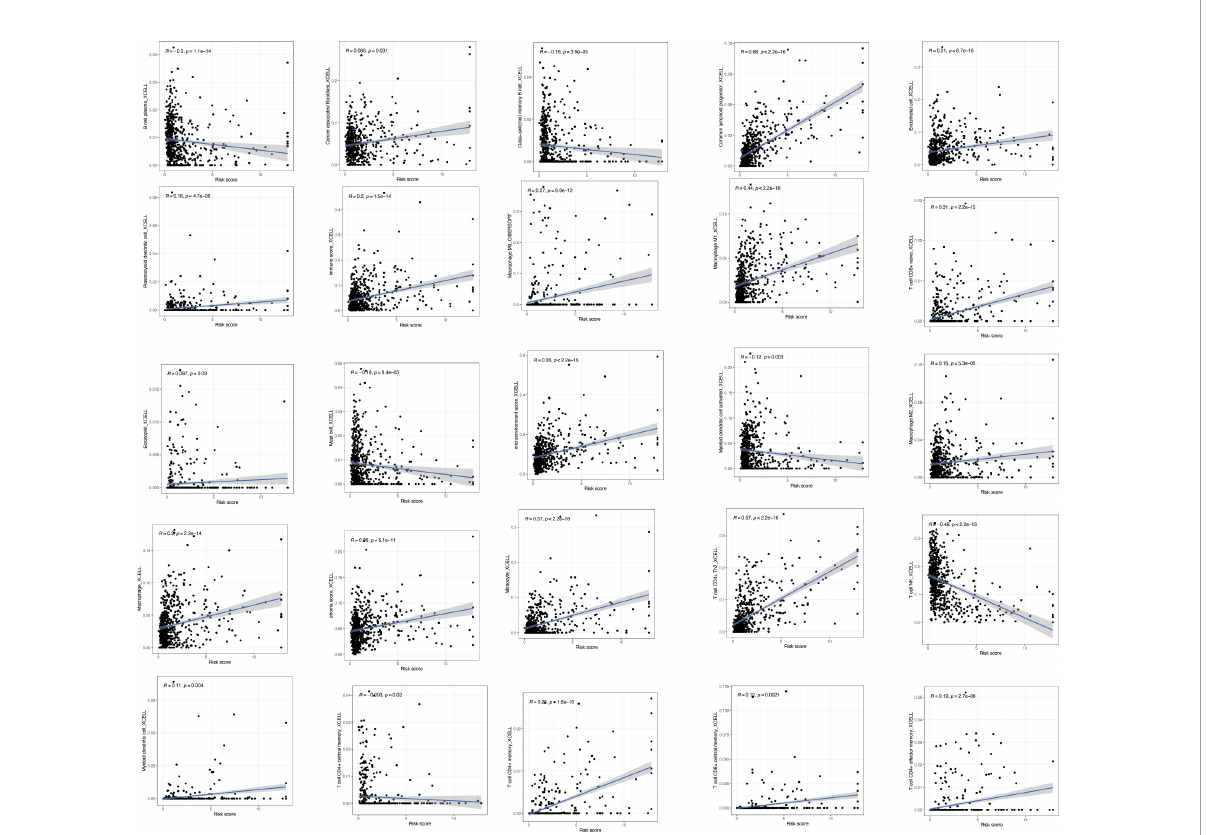
FIGURE 8 Immune correlation analysis based on NRlncRNAs. Various immune cells are involved in NRlncRNA expression. NRlncRNAs, necroptosis-related long non-coding